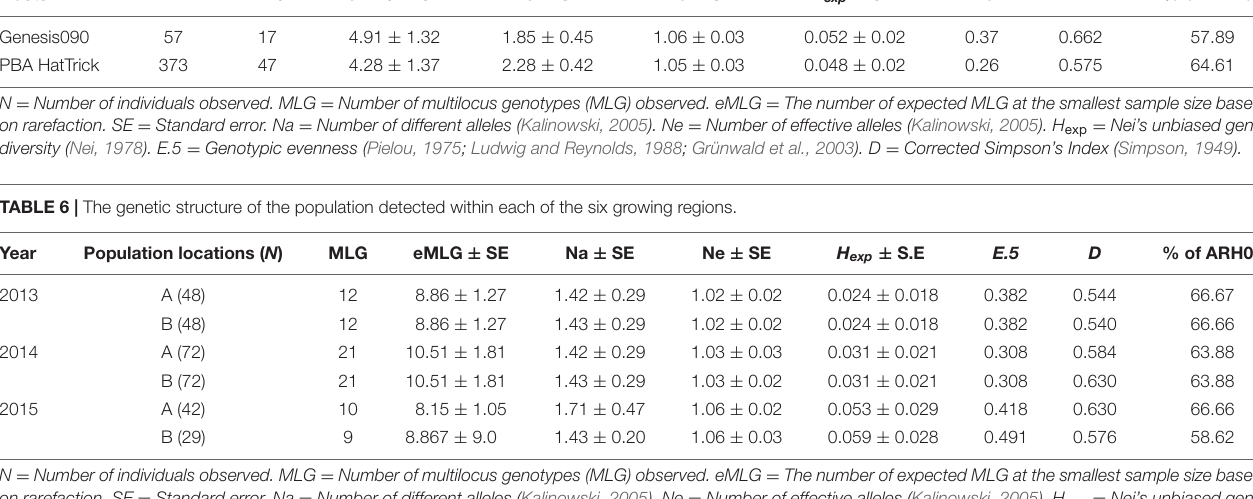
TABLE 5 | The genetic structure of the A. rabiei population detected on two widely adopted host genotypes. Hosts